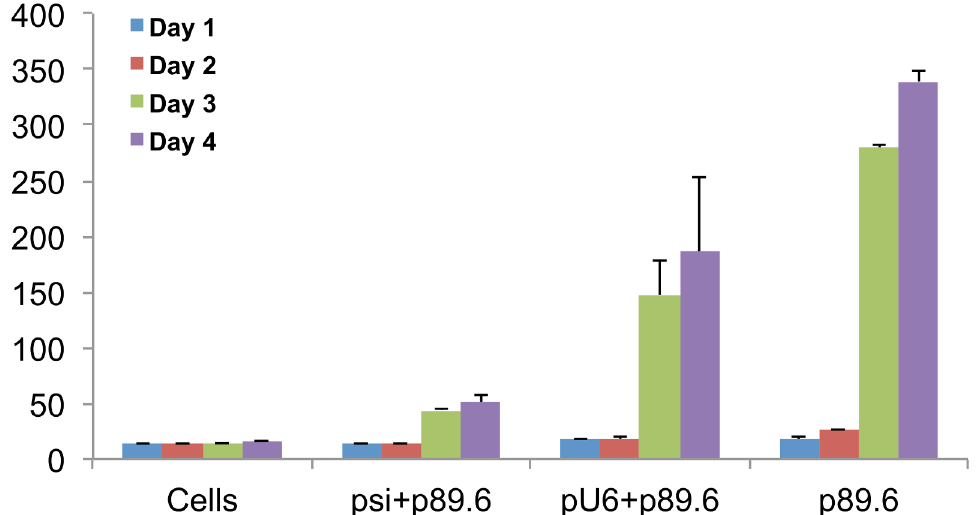
Fig 5. Inhibition of HIV-1 replication by siRNAs using 3D VEC model. The 3-D VEC tissues were co-transfected with cocktail plasmid siRNAs-chlipid nanocomplexes or pU6 vector control-chlipid nanocomplexes or chlipid complexes alone with no plasmids. A p24 ELISA was performed on supernatants collected on days 0, 2, and 3 post-infection and p24 concentrations (pg/ml) were measured using p24-ELISA. Assays were run in duplicate on supernatants collected and expressed as mean p24 concentration in pg/ml ± SEM.